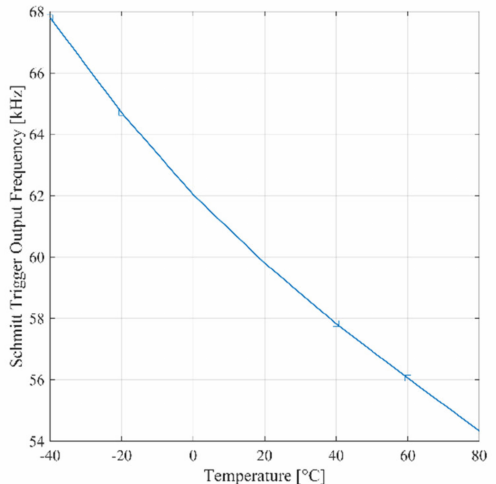
Figure 7. Monte Carlo simulation results with a frequency variation of 245 kHz ( ∆ C i = 4.1